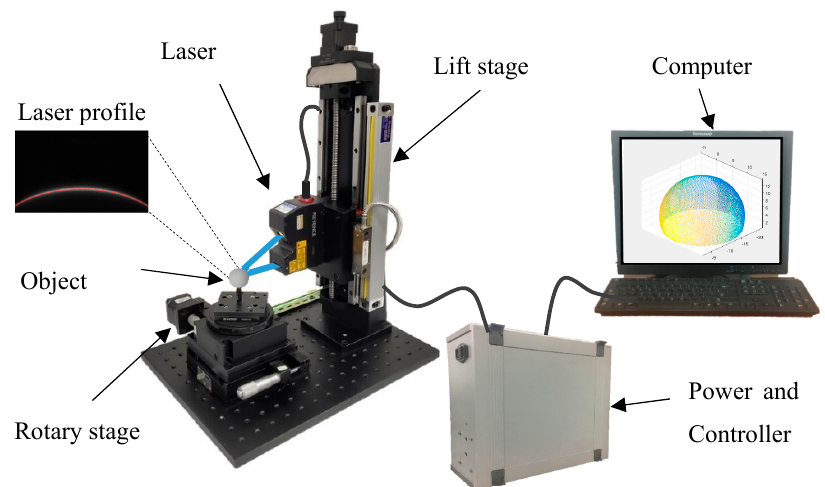
Figure 1. Schematic of the experimental setup for the 3D scanning system.